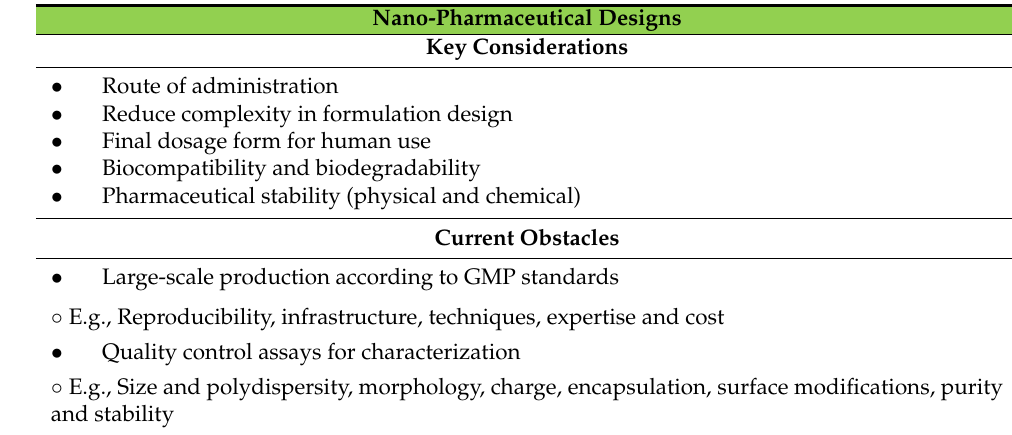
Table 3. Various factors for consideration for the translational development of nanomedicines (reproduced with permission from